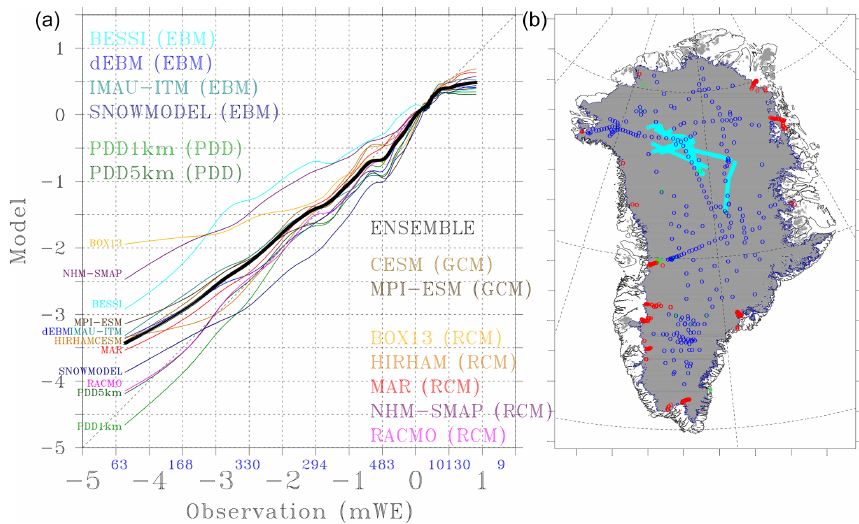
Figure 5. (a) Scatter plot of modelled vs. measured SMB in mw.e.. To increase the visibility of this figure, a running mean of 200 samples has been applied here after having sorted the samples (observation, model) on the observations. The numbers in blue on the x axis indicate the number of observations with SMB values within each interval of the x axis. (b) Locations of the in situ measurements: ice cores in dark blue, airborne radar transects in light blue, snow pits in green and PROMICE in red.